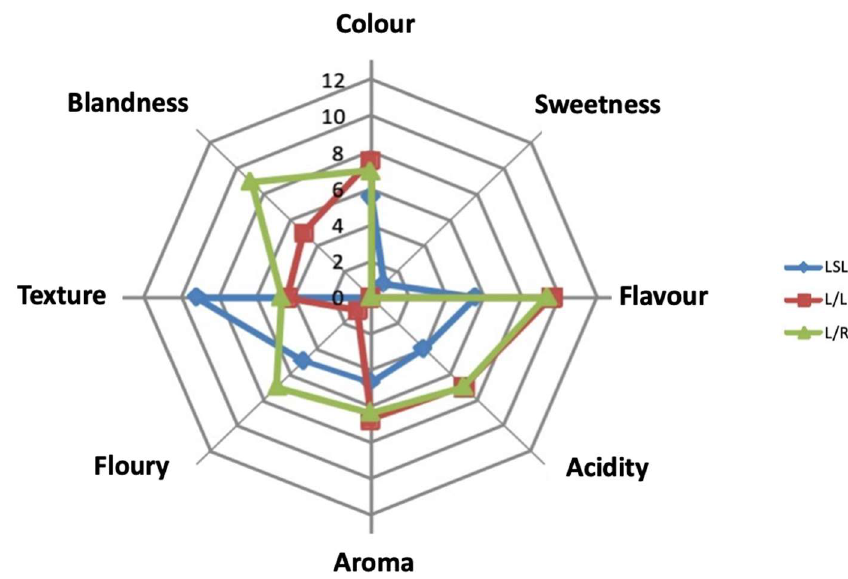
Figure 12. Sensory attributes of fruit: colour, sweetness, flavor, acidity, aroma, floury, texture and blandness as perceived by the expert panel by treatments LSL (long-shelf-life tomato), L/L (self- grafted Old Limachino tomato) and L/R (grafted Old Limachino tomato on Poncho Negro rootstock) under greenhouse conditions.